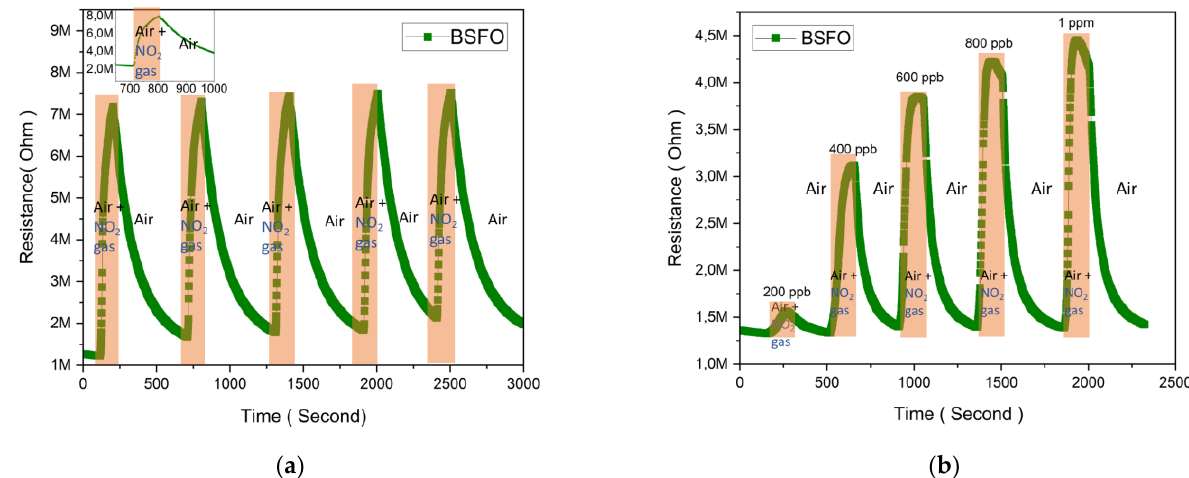
Figure 7. Transient response curves of BSFO. ( a ) Repeatability towards 2 ppm of NO 2 at 260 °C. ( b ) Dynamic sensing characteristics to different concentration of NO 2 at 260 °C.